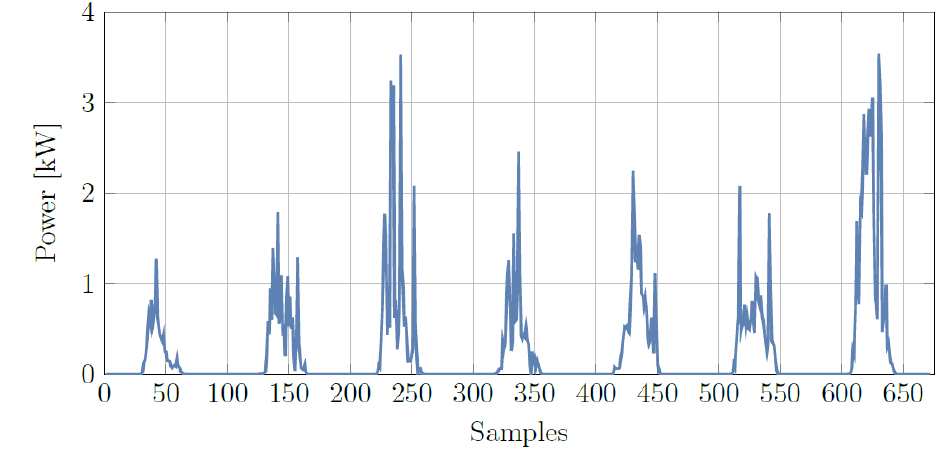
Figure 7. Trends of produced power referred to autumn period from 30 October 2020 to 5 November 2020. Days show significant irregularity and the produced power is not characterized by typical profiles; it also assumes the lower value with respect to other seasons.